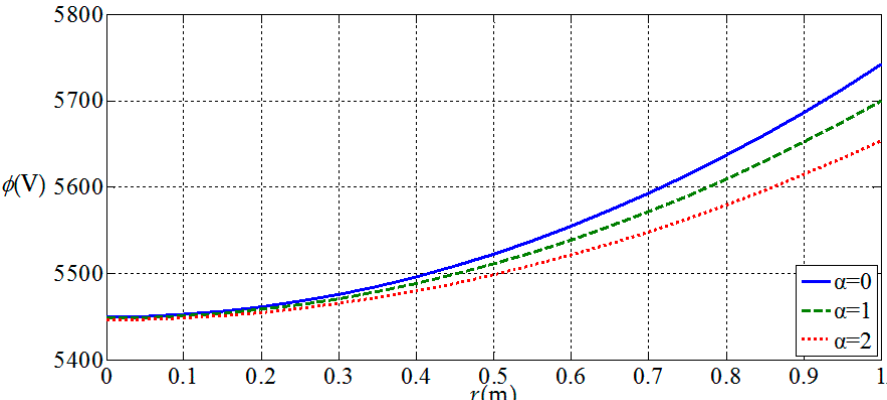
Figure 13. Variation of electric potential φ ( r , h /4 ) with coordinates r at z = h